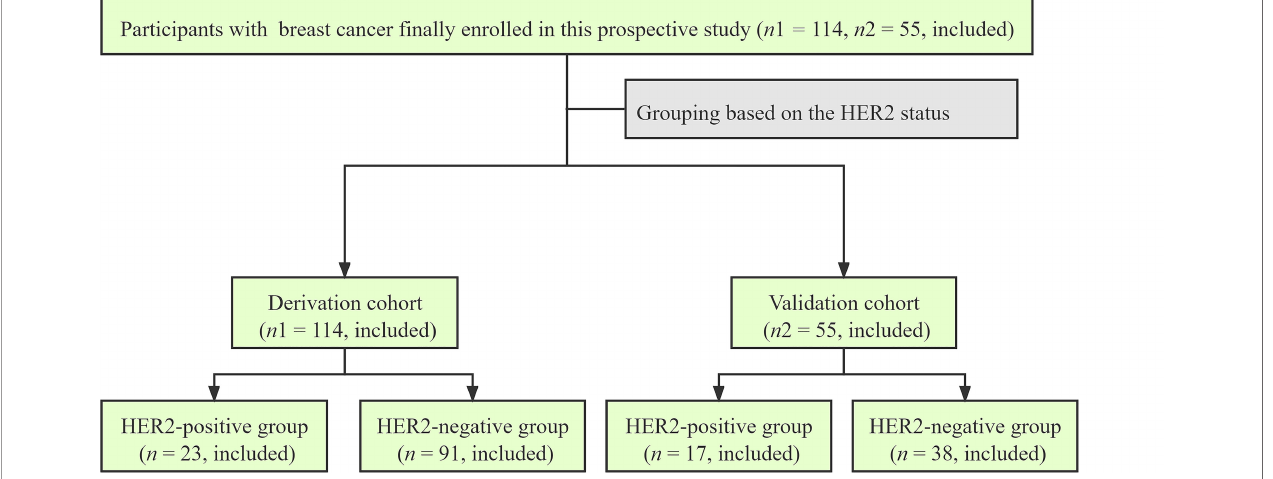
FIGURE 1 | Flowchart shows the enrollment of the participants in the derivation and validation